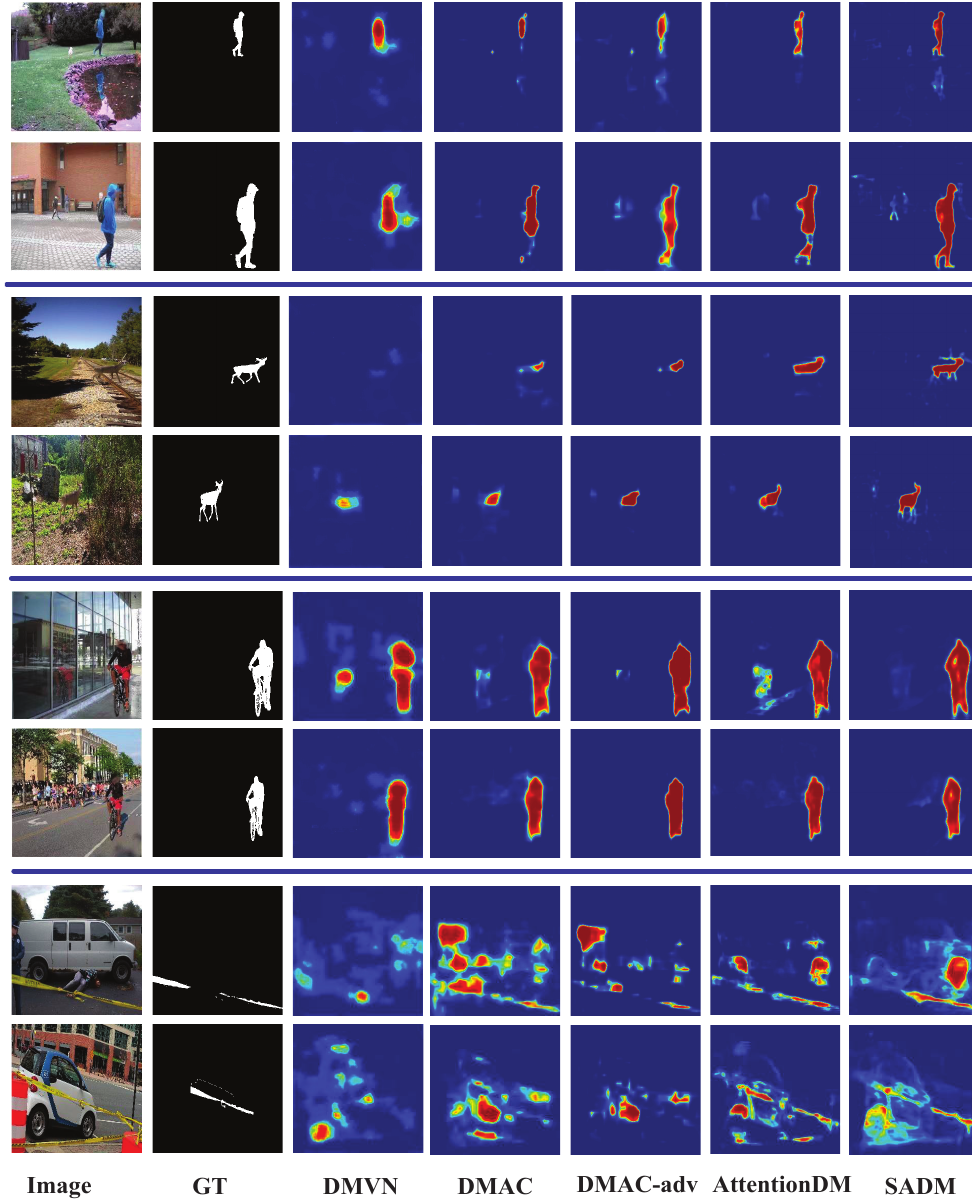
Figure 8. Visual comparisons on the MFC2018